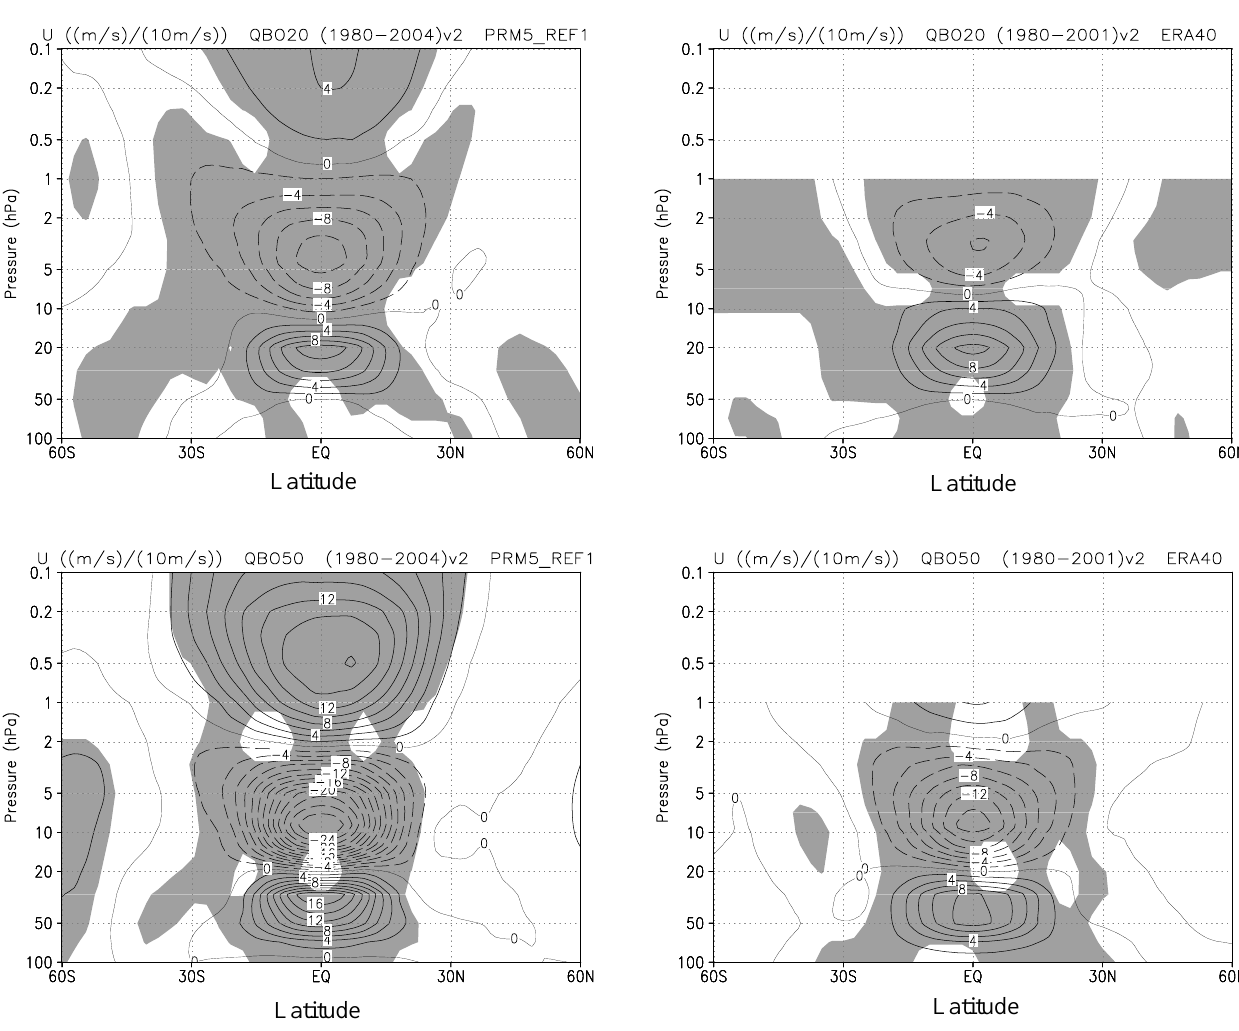
Fig. 12. Latitude-pressure cross sections of the QBO20 (upper) and QBO50 (lower) zonal winds in m/s per 10m/s of the QBO winds at 20 and 50hPa between 60 ◦ S and 60 ◦ N for the simulation (left) and observation (ERA-40) (right). Contour interval is 2(m/s)/(10m/s), and shading denotes the 95% confidence level (t-test).